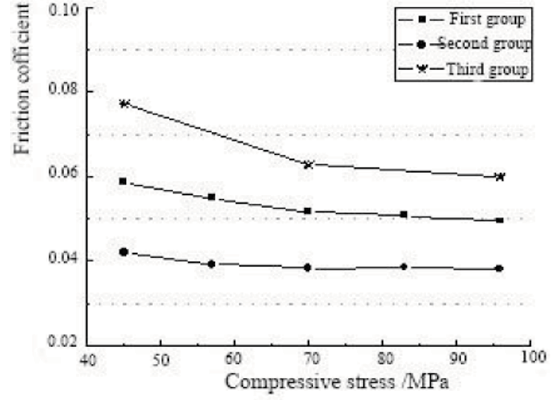
Figure 9. The friction factor under the different pressure It shows the friction efficient is smaller and smaller as the vertical pressure is increasing. The friction efficient of the second group is smaller than the first group. It indicates that the friction factor is related